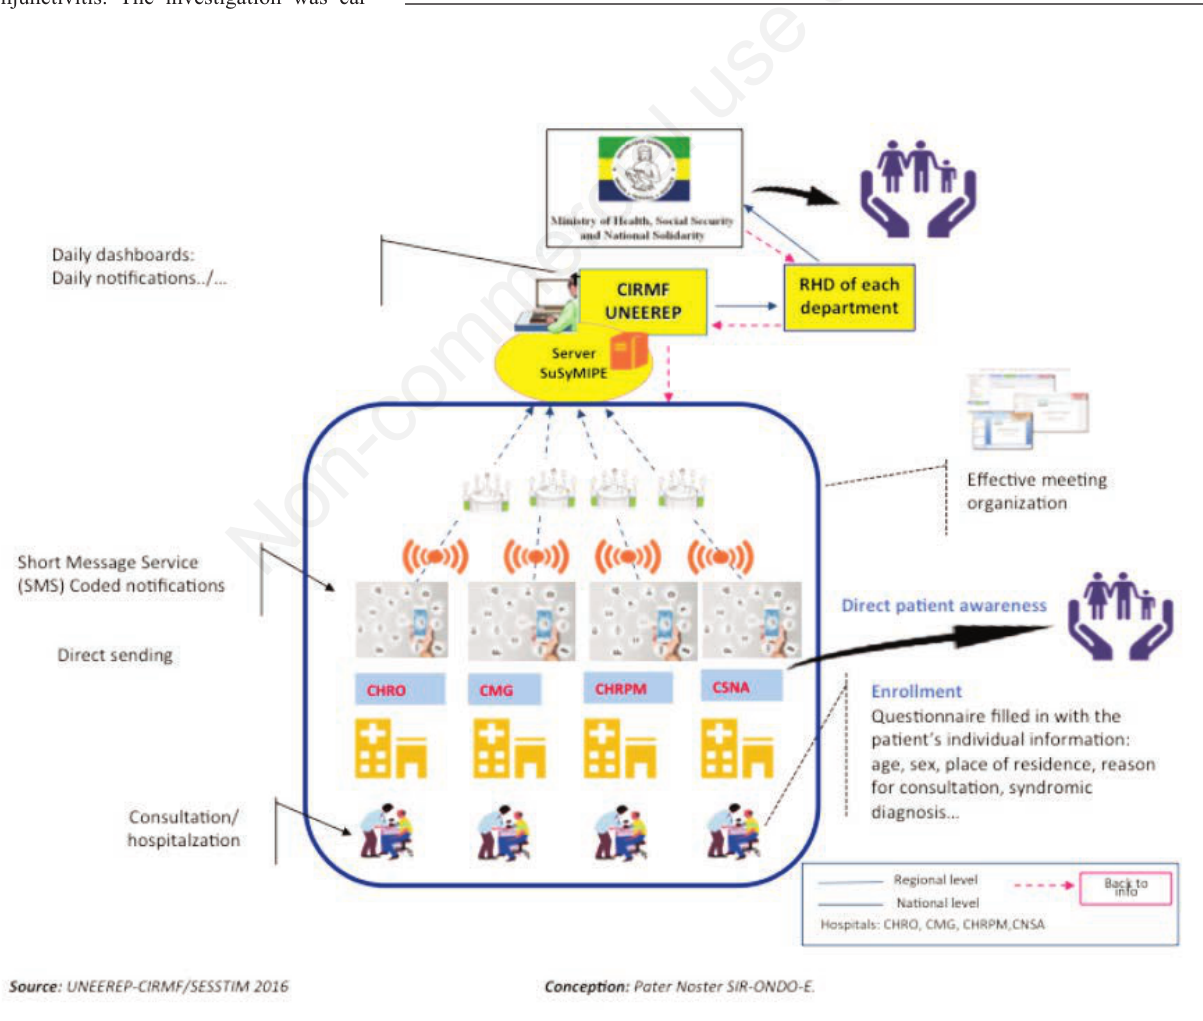
Figure 1. Geographical location of cases reported during the measles outbreak, Libreville- Oyem, March-May 2016.